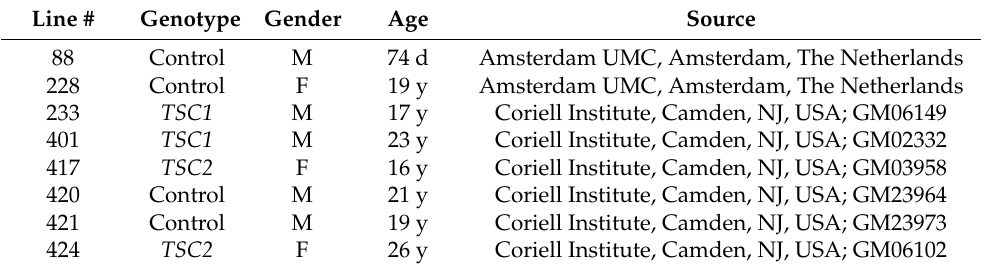
Table 1. Overview of induced pluripotent stem cells (iPSC)